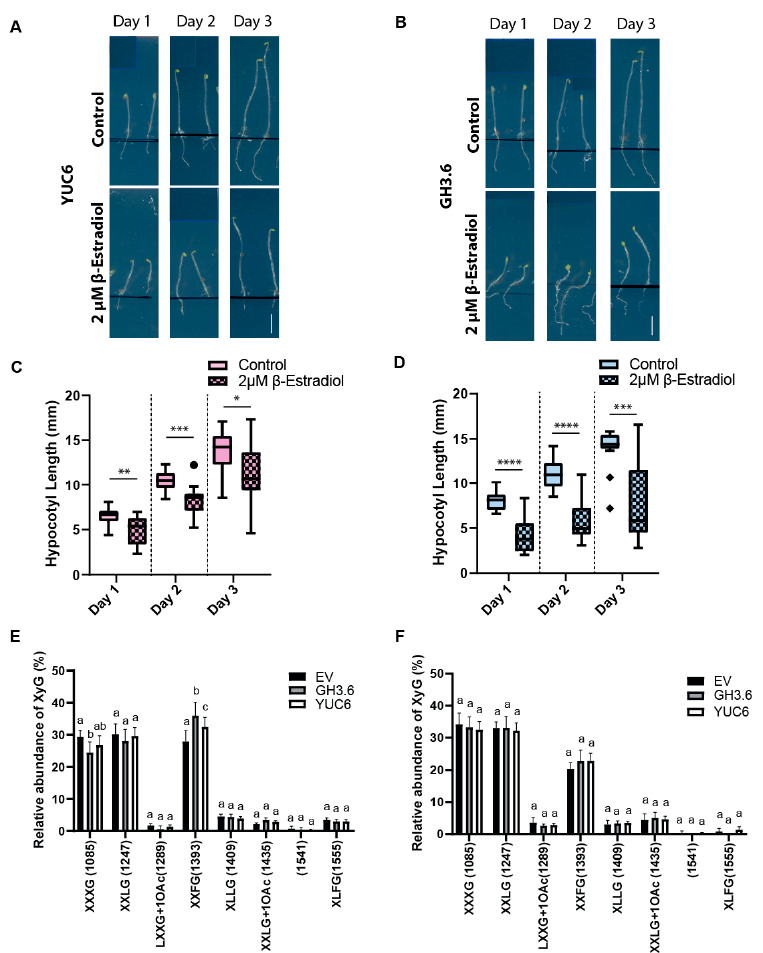
Figure 4. ( A – D ) Hypocotyl growth phenotype of estradiol inducible YUCCA6 (YUC6), GRETCHEN-HAGEN3.6 (GH3.6) and empty vector control (EV). Three-day-old seedlings were transferred onto 2 µM estradiol or control plates and left for one, two or three days. ( A , B ) Representative images of YUC6 ( A ), GH3.6 ( B ) on control media or estradiol-containing media after one, two or three days of induction. Scale bar = five mm. Please note that distracting labels on the scanned plate were removed by covering them with blue boxes (outlined by light blue lines). ( C , D ) Quantification of hypocotyl length (mean ± SD) of YUC6 ( C ) and GH3.6 ( D ). t -test with p -value <0 .05. (n = 3 biological replicates with 5–10 seedlings each). ( E , F ) Oligosaccharide mass profiling (OLIMP) on upper (growing part) ( E ) and lower (non-growing part). ( F ) sec- tions of hypocotyls of inducible GH3.6, YUC6 and empty vector control (EV). All lines were induced for three hours with 10 µM ß-estradiol. Data are mean ± SD (n = 4 biological replicates). *: p -value ≤ 0.05, **: p -value ≤ 0.01, ***: p -value ≤ 0.001, ****: p -value ≤ 0.0001. Similar letters in the graphs mark no significant statistical difference. Different letters in the graphs mark significant statistical difference with a p -value < 0.05. XyG: Xyloglucan. XyG sidechains ’nomenclature: G (Glucose), X (Glucose+Xylose), L (Glucose+Xylose+Galactose), F (Glucose+Xylose+Galactose+Fucose), Ac: Acetyl group.